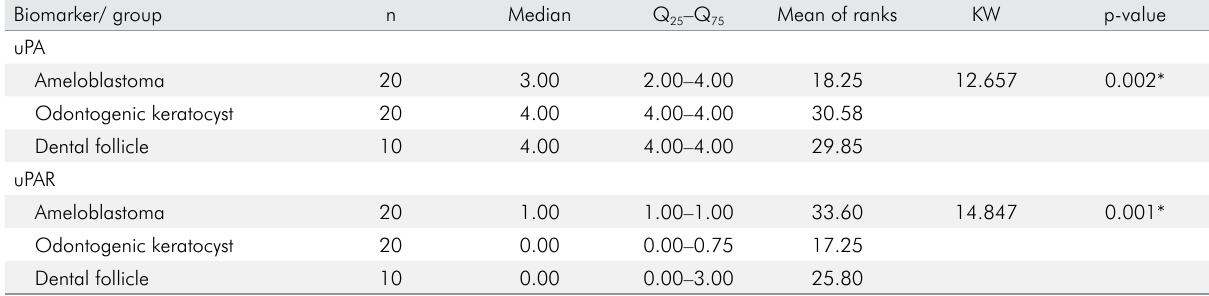
Table 2. Parameters used for the calculation of the Kruskal-Wallis (KW) test for the evaluation of the epithelial scores of immunoexpression of uPA, uPAR, and PAI-1 in ameloblastomas, odontogenic keratocysts and dental follicles.